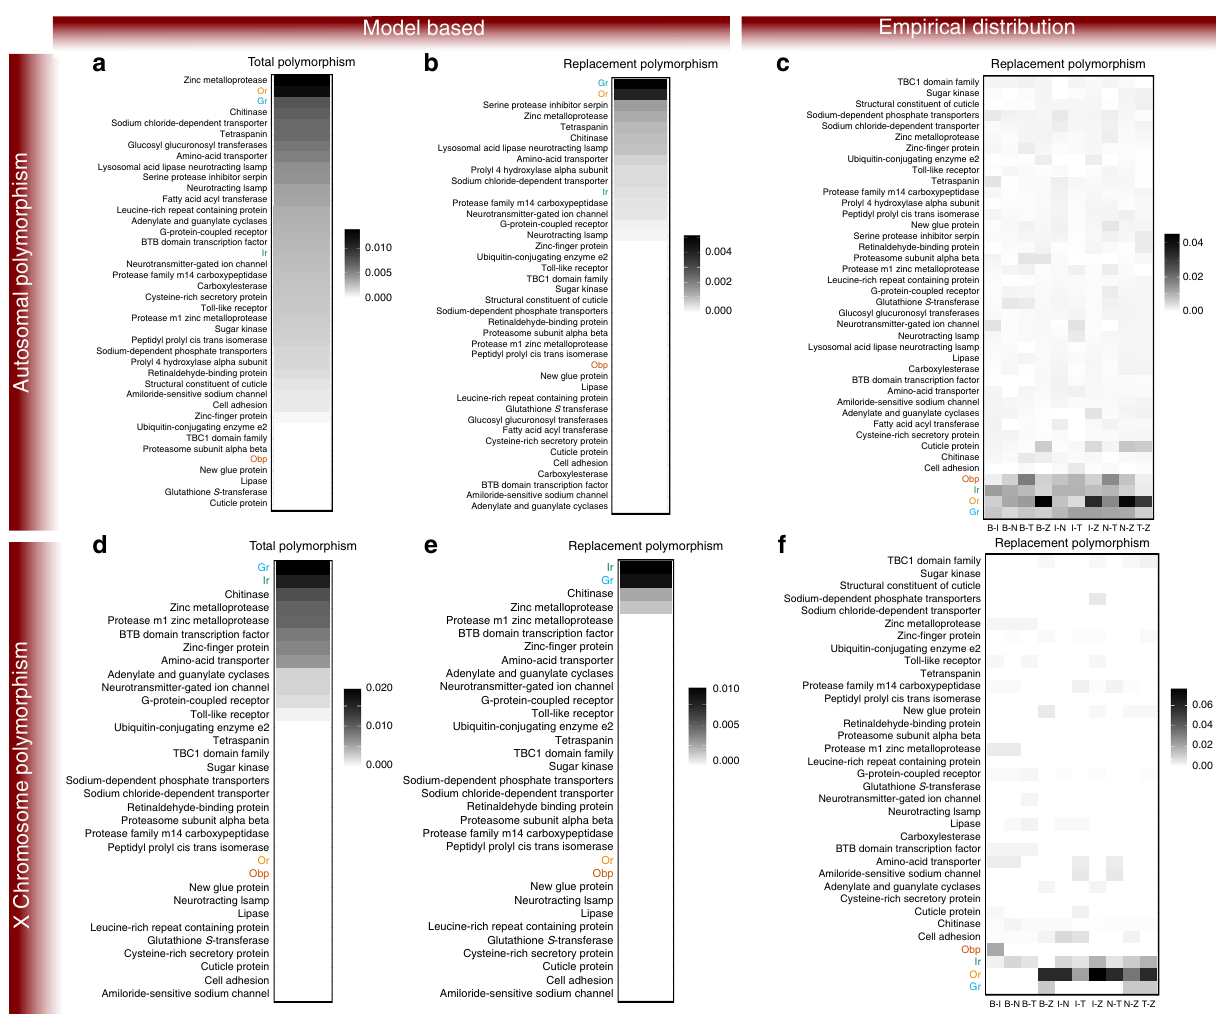
Figure 3 | Chemosensory families show strong population differentiation ( F st ). Heatplots summarizing the fraction of loci identified as positive selection candidates. The left two columns ( a , b , d , e ) display results from a model-based approach (BayeScan), summarizing either the total data (total polymorphism) or data for replacement polymorphism only (replacement polymorphism). The third column ( c , f ) displays results from an empirical-distribution outlier approach, using the 1% F st tail as the cutoff. The top row displays results for the autosomal data; the bottom row displays data for the X chromosome. Values shown in the scale bars are the total number of outliers identified in the given analyses divided by the total number of SNPs in the same